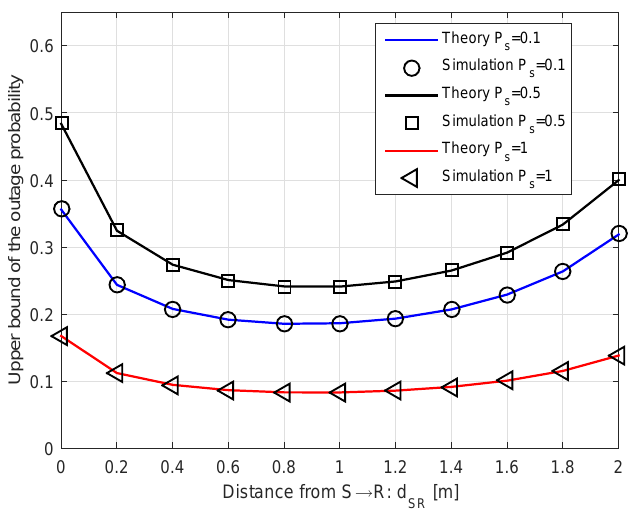
Figure 3. The outage probability versus the